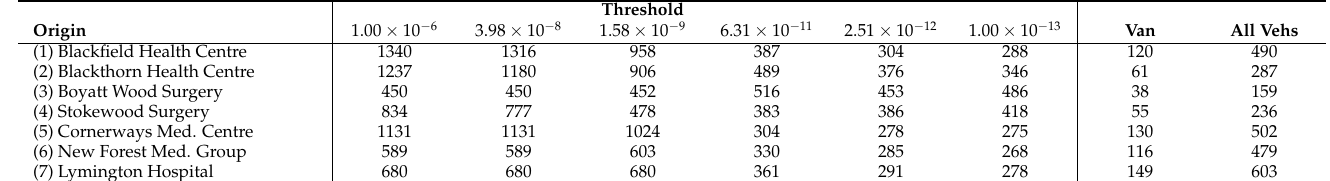
Table 3. Fatality rates per billion journeys for each threshold/mode and origin. Destination is Southampton General Hospital in all cases.